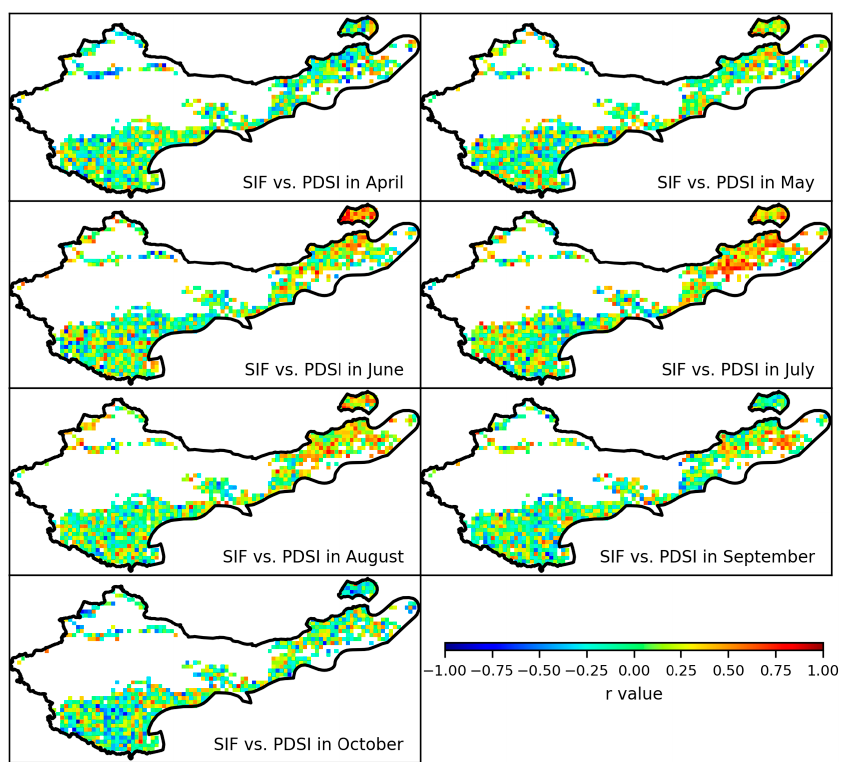
Figure 5. Spatiotemporal distribution of the correlation coefficients between SIF and PDSI in each month of growing season. Pixels with white color mean non-grassland or missing data. ISPRS Int. J. Geo-Inf. 2020 , 9 , x FOR PEER REVIEW